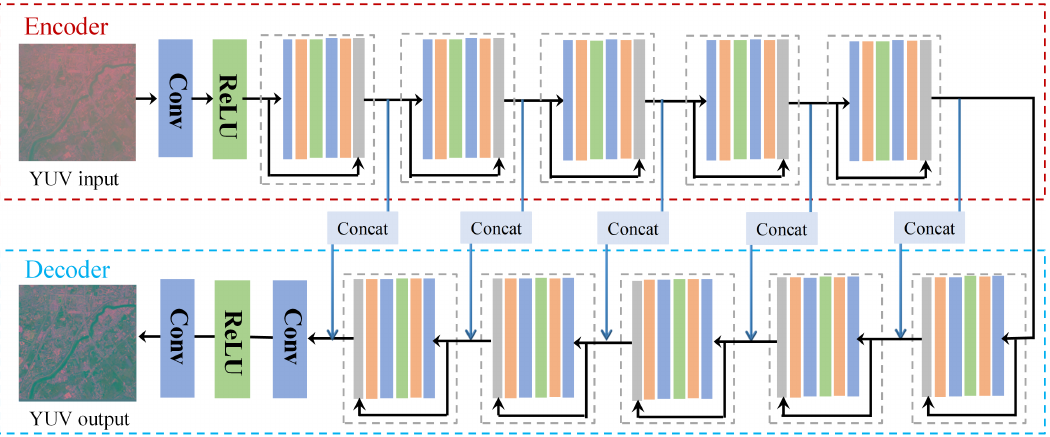
Figure 4. Architecture of the